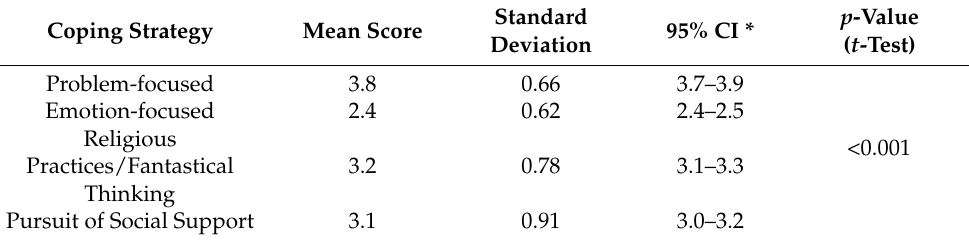
Table 2. Mean scores of the coping strategies of primary healthcare workers in S ã o Jos é do Rio